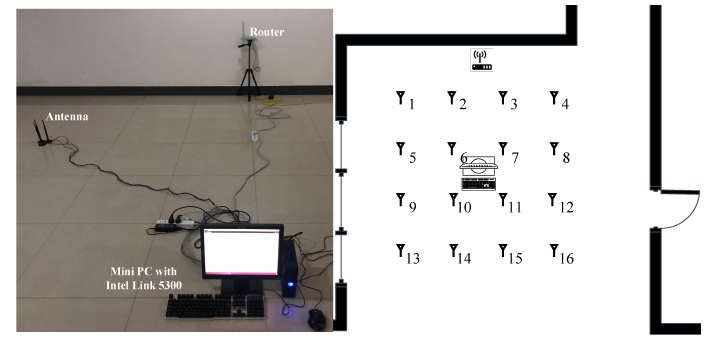
Figure 6. Experiment scene and floor plan of the